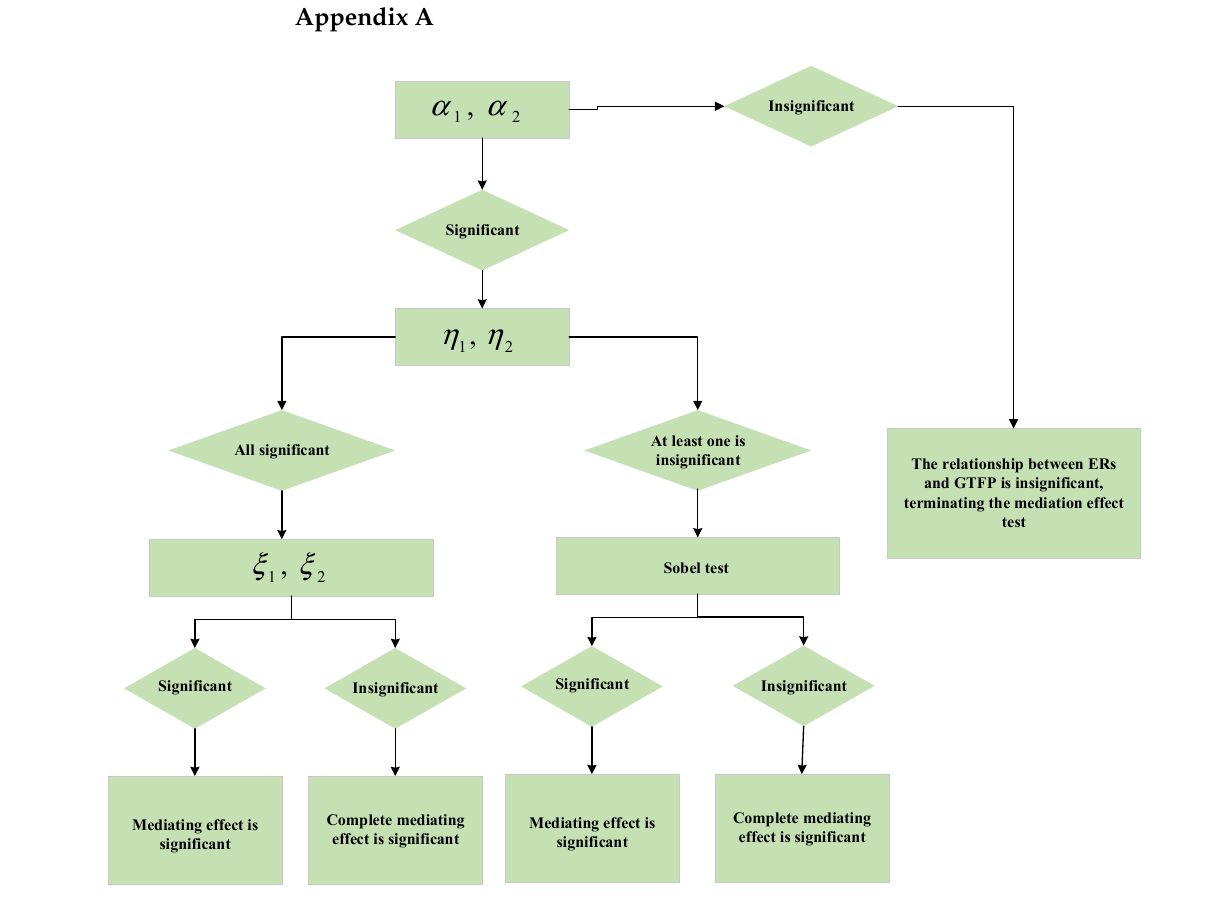
Figure A1. Detailed Procedures of the Mediating Effect Test.